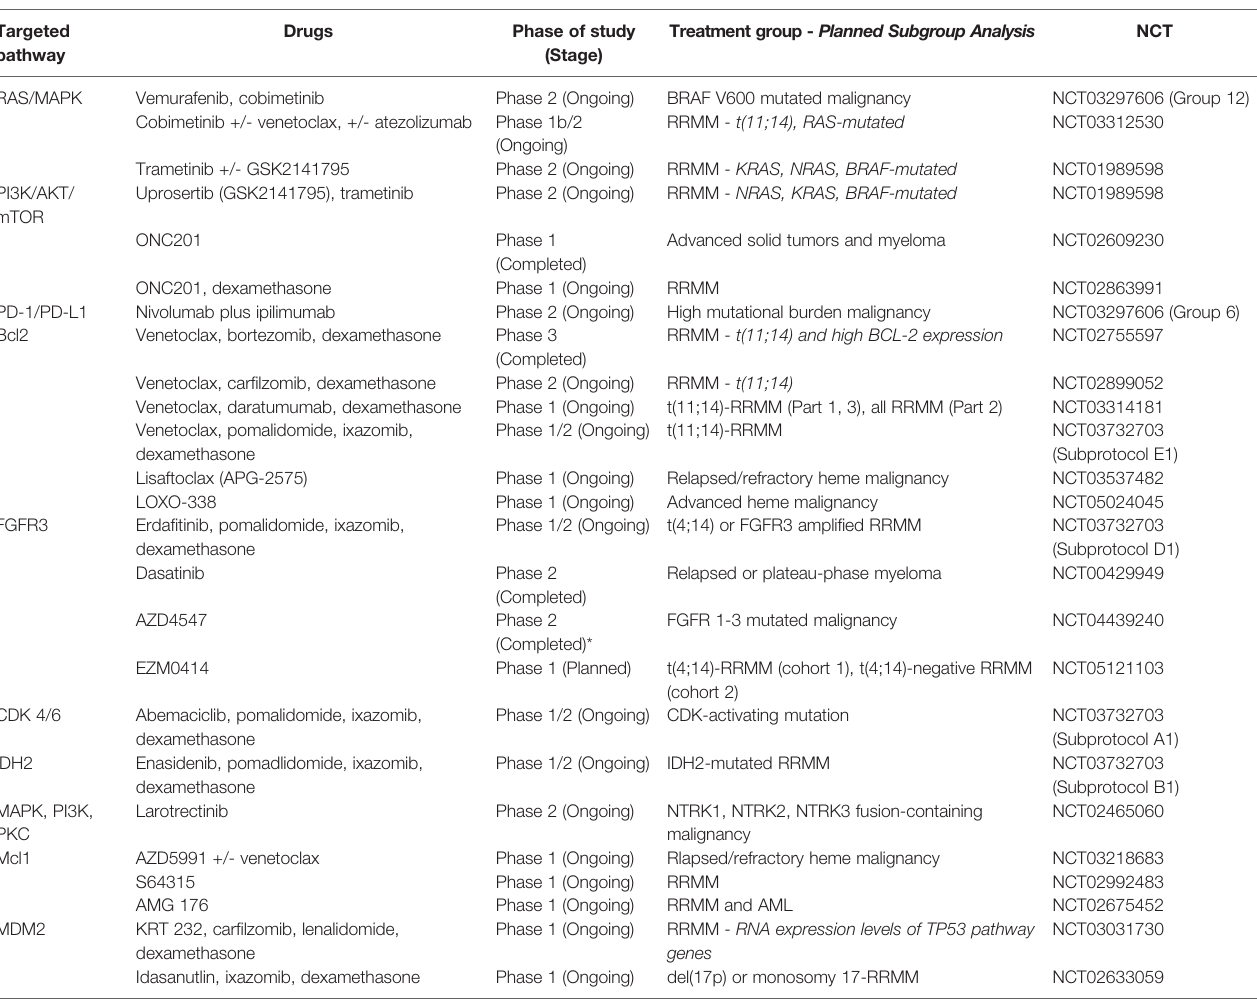
TABLE 1 | Overview of multiple myeloma trials targeting pathways and relevant subgroups. Targeted